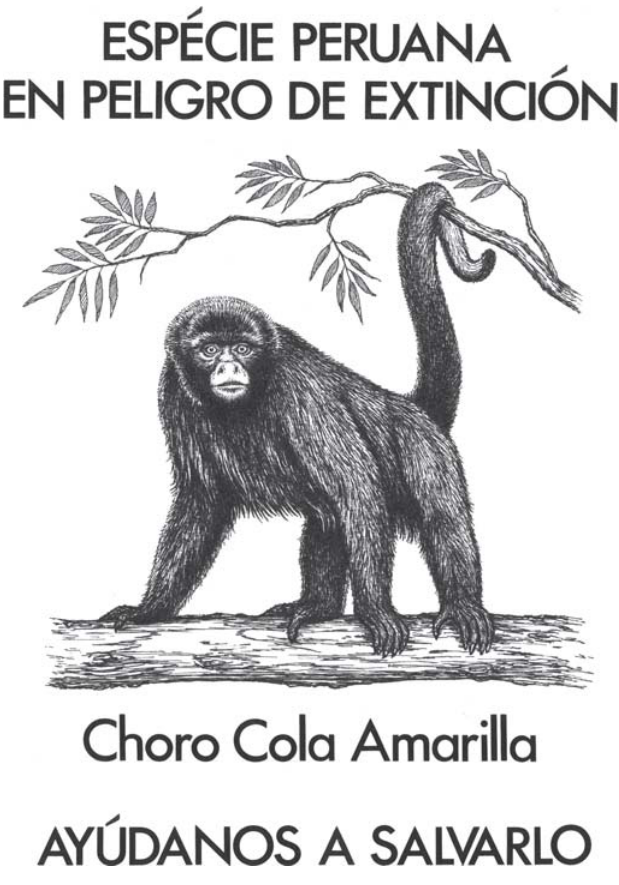
Image 11. The Yellow-tailed Woolly Monkey design used for stickers and t-shirts in the campaign. (Illustration by